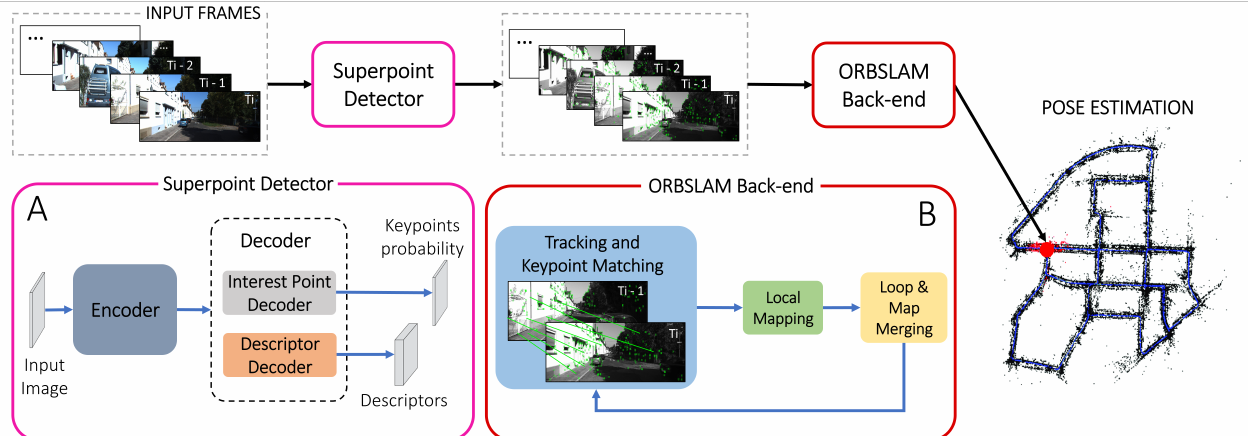
Figure 1. The figure depicts the integration of the Superpoint feature detector and descriptor into the ORB-SLAM3 pipeline. The traditional ORB and BRIEF feature detection and description methods have been replaced with the Superpoint pipeline. The input images are transformed into the grayscale format and fed into the Superpoint detector pipeline ( A ). The Superpoint encoder–decoder pipeline is composed of a learned encoder, based on several convolutional layers, and two non-learned decoders for the joint features and descriptors extraction. The detected features are then processed by the ORBSLAM3 back-end, which consists of three main components that operate as three parallel threads: the Tracking, Local Mapping, and Loop & Map Merging threads ( B ). The back-end extracts keyframes, initializes and updates the map, and performs motion and pose estimation, both locally within the Local Mapping Thread and globally within the Loop & Map Merging thread. If a loop closure is detected, the pose estimation is further